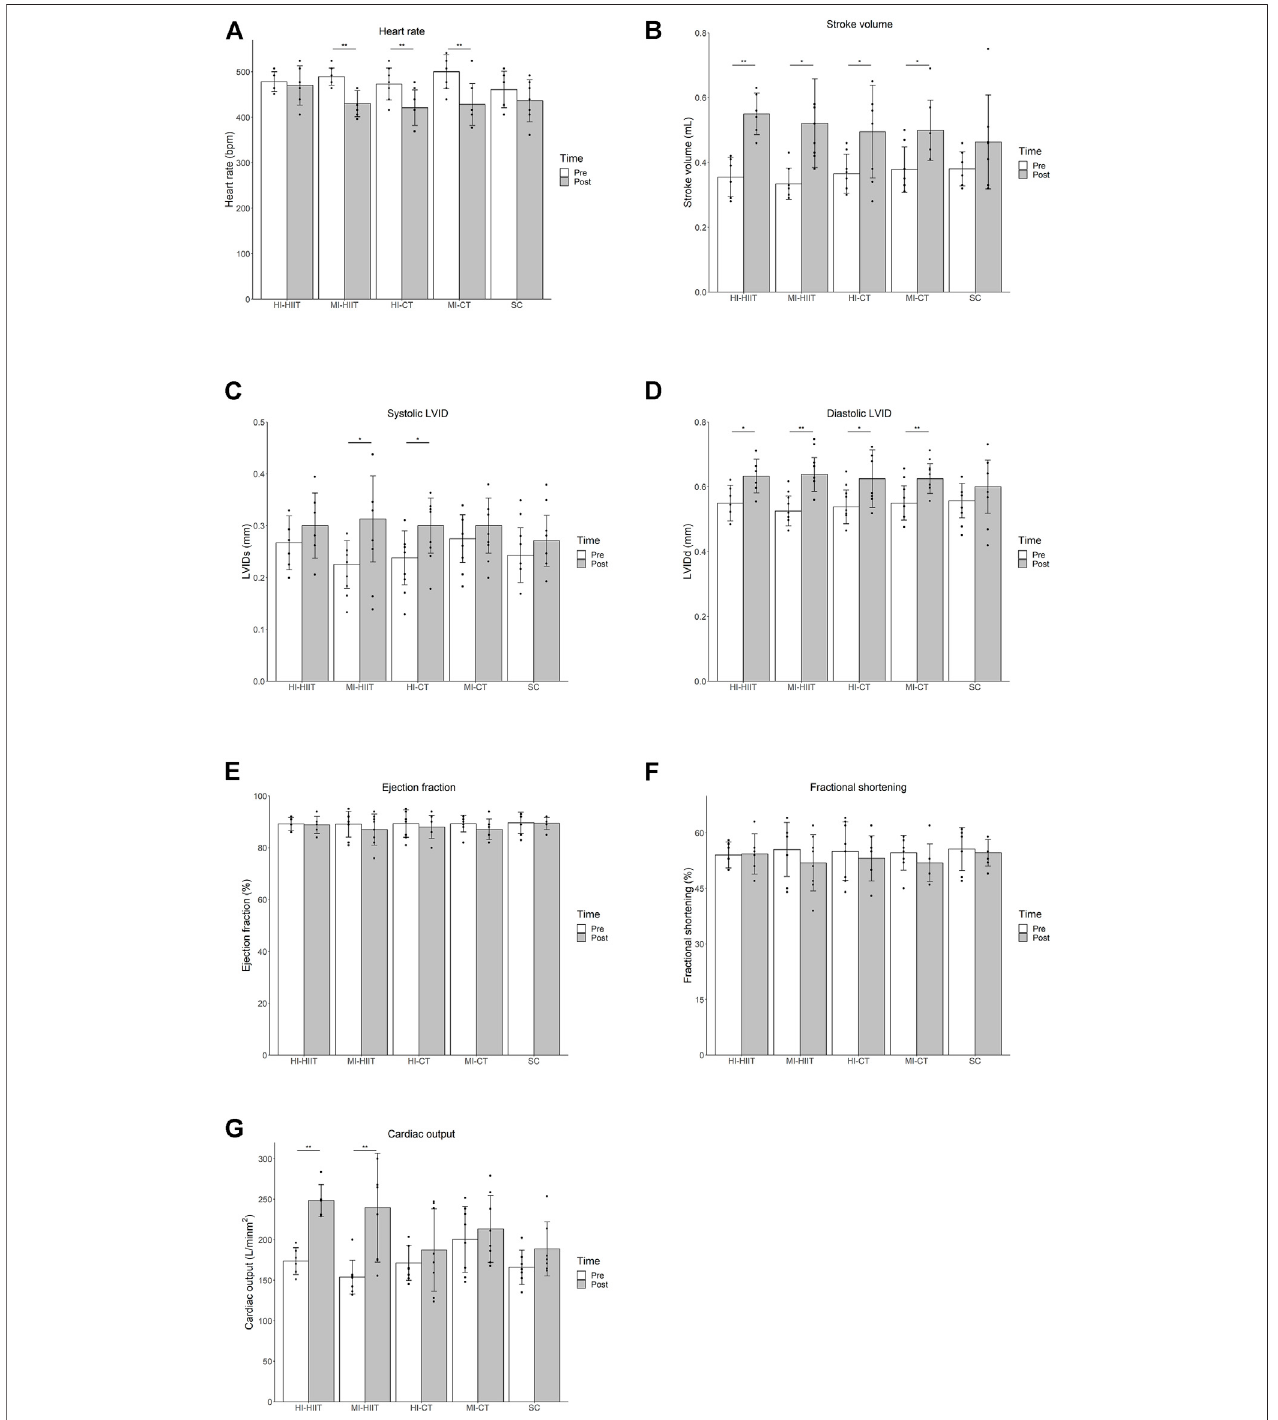
FIGURE1|(A) Signi fi cantheartratedeclinewasfoundintheMI-HIIT, HI-CTandMI-CTgroupaftertraining. (B) Strokevolumeincreasedsigni fi cantlyinallexercise groups after training. (C) Systolic LVID increased in MI-HIIT and HI-CT groups after training. (D) Diastolic LVID increased in all exercise groups after training. (E) No signi fi cant change in ejection fraction was found in exercise groups after training. (F) No signi fi cant change in fractional shortening was found in exercise groups after training. (G) Signi fi cant increase in cardiac output was found in HIIT groups after training. HI-HIIT: high training intensity HIIT group; MI-HIIT: moderate training intensity HIIT group; HI-CT: high training intensity CT group; MI-CT: moderate training intensity CT group; SC: sedentary control group; LVID: left ventricular intraventricular diameter. *: p < 0.05; ** p < 0.01.